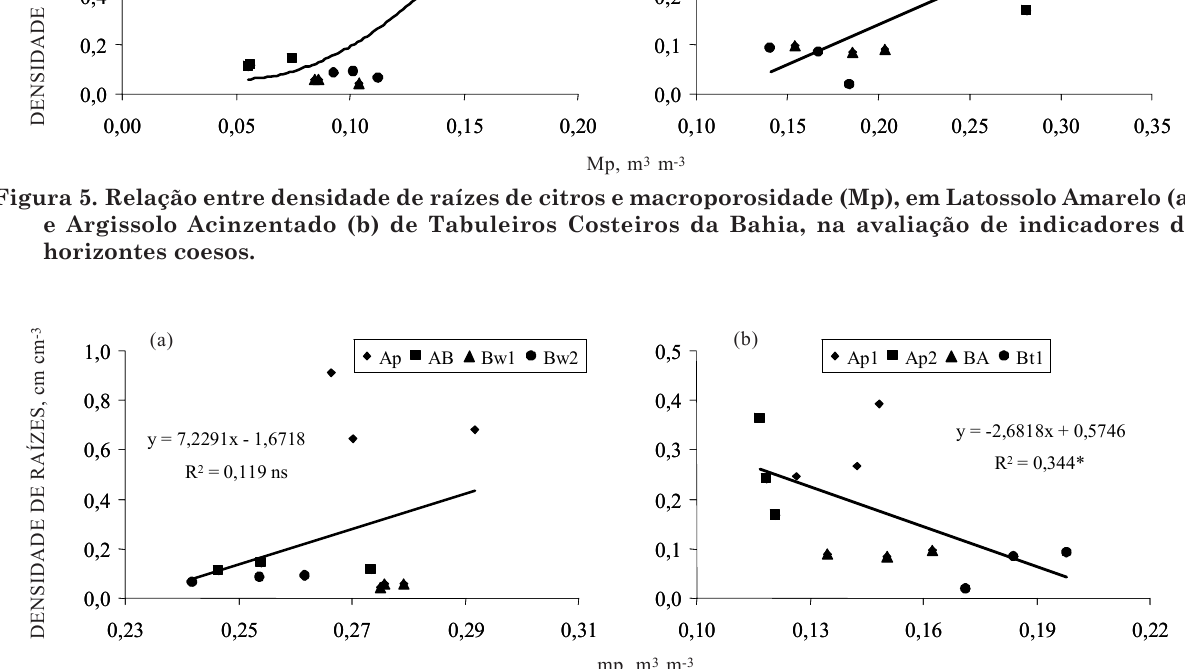
Figura 6. Relação entre densidade de raízes de citros e microporosidade (mp), em Latossolo Amarelo (a) e Argissolo Acinzentado (b) de Tabuleiros Costeiros da Bahia, na avaliação de indicadores de horizontes coesos.